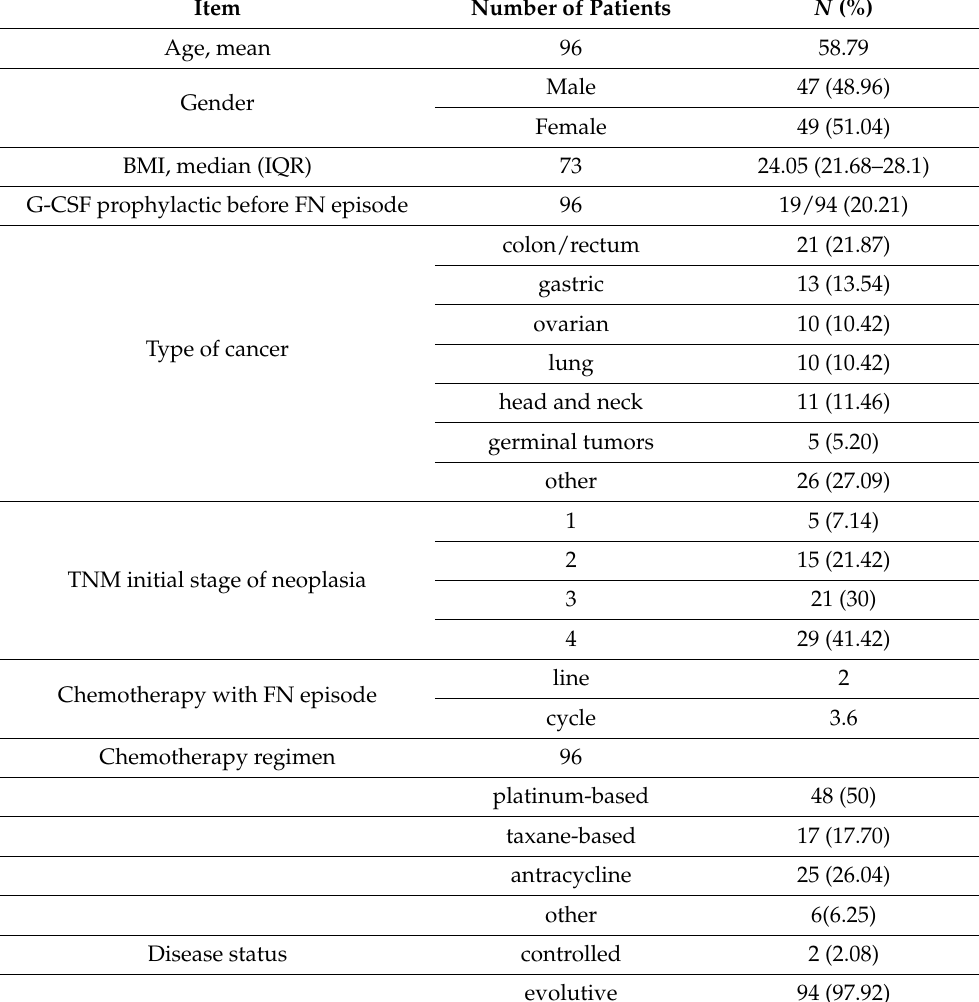
Table 1. Main characteristics of the enrolled patients.